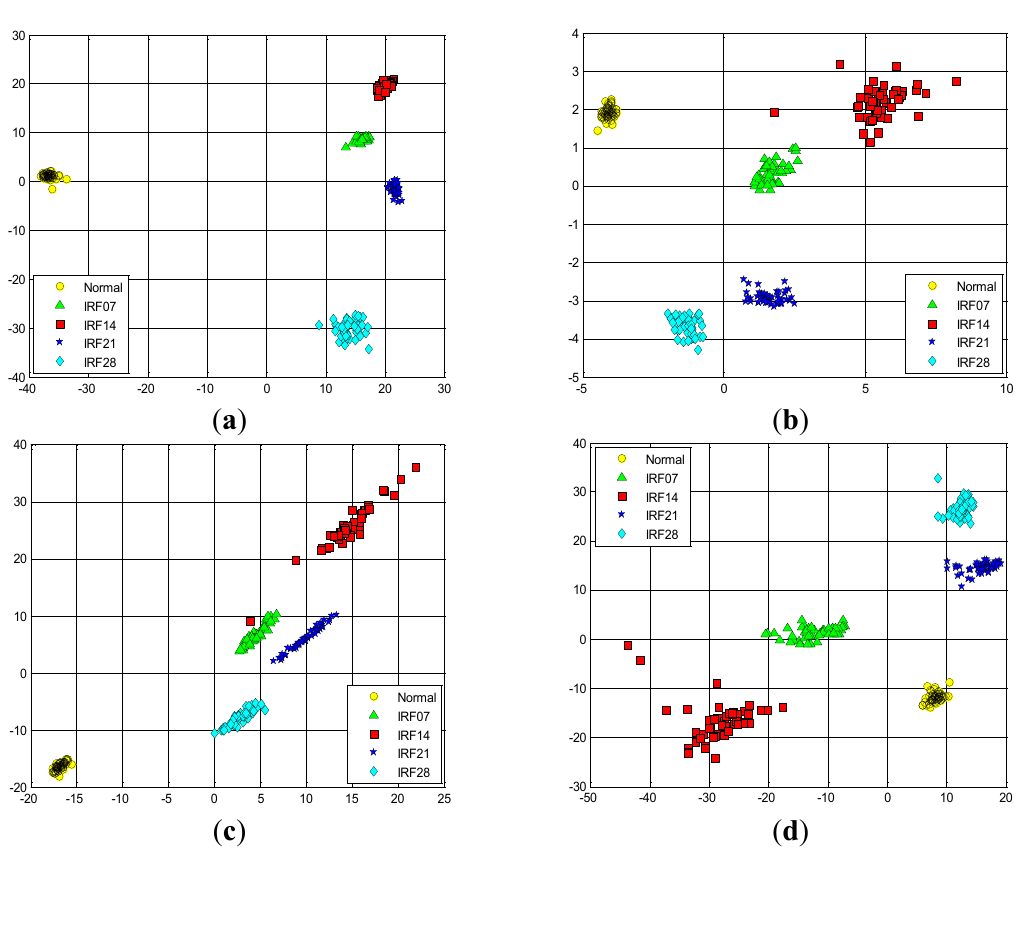
Figure 15. The data projection result with the first two eigenvectors in the D_IRF